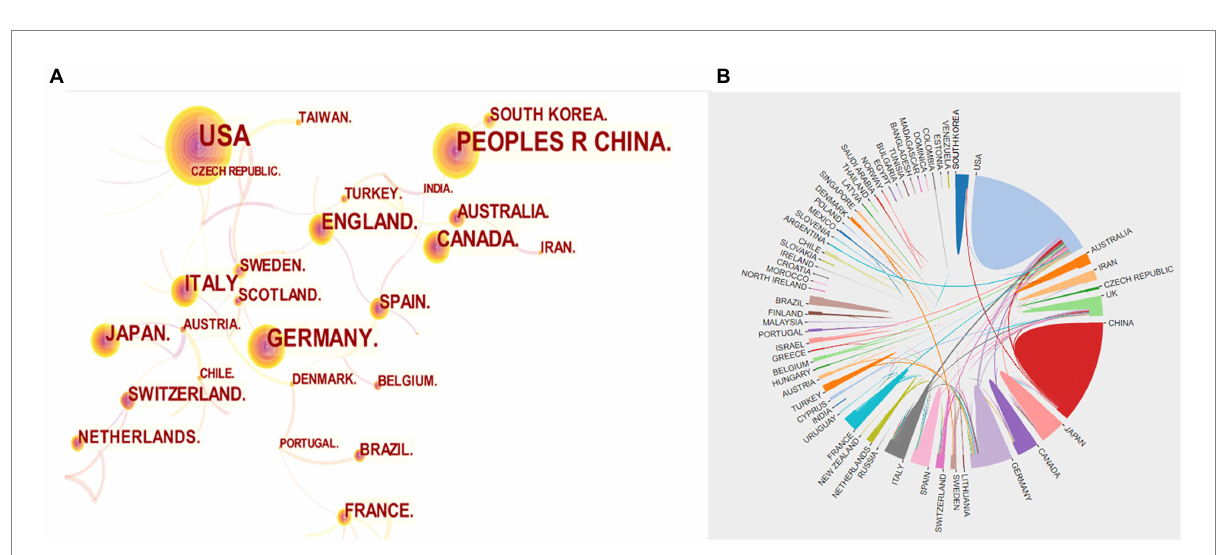
FIGURE 3 (A) Visualization map of countries co-occurrence. (B) Collaboration analysis among different